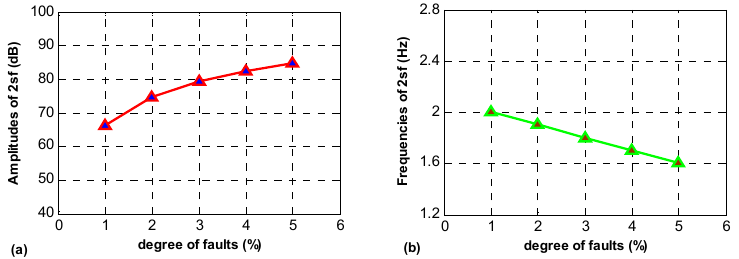
Figure 14. Influence of the degree of faults on the ( a ) amplitude and the ( b ) frequency of the 2· s · f s spectral components.